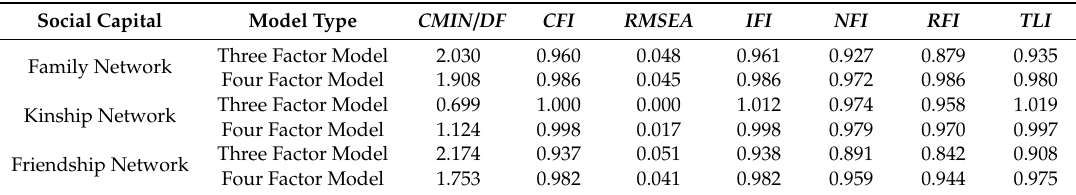
Table 1. The output values of goodness of fit index.